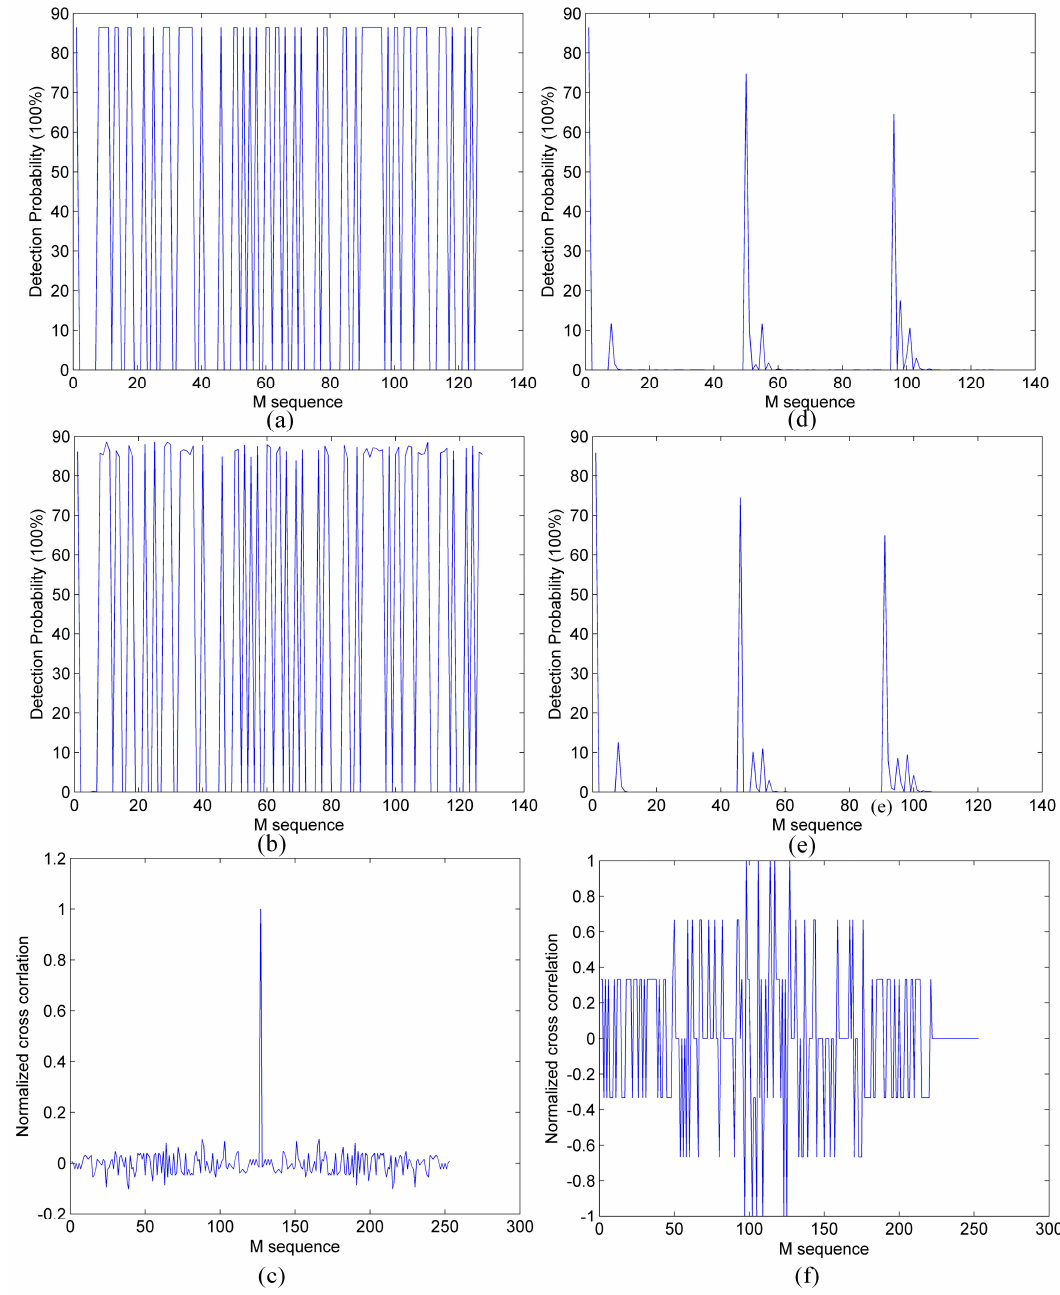
Figure 3. The detection probability of each code in pseudo-random single-photon counting ranging (PSPCR) Lidar system and the cross-correlation function. (a) and (d) are the PSPCR method detection probabilities of theory derivation while the dead time is 0 and 45 ns, respectively; (b) and (e) are the PSPCR method detection probabilities of Monte Carlo simulation while the dead time is 0 and 45 ns, respectively; (c) and (f) are the normalized cross-correlations of the PSPCR method.